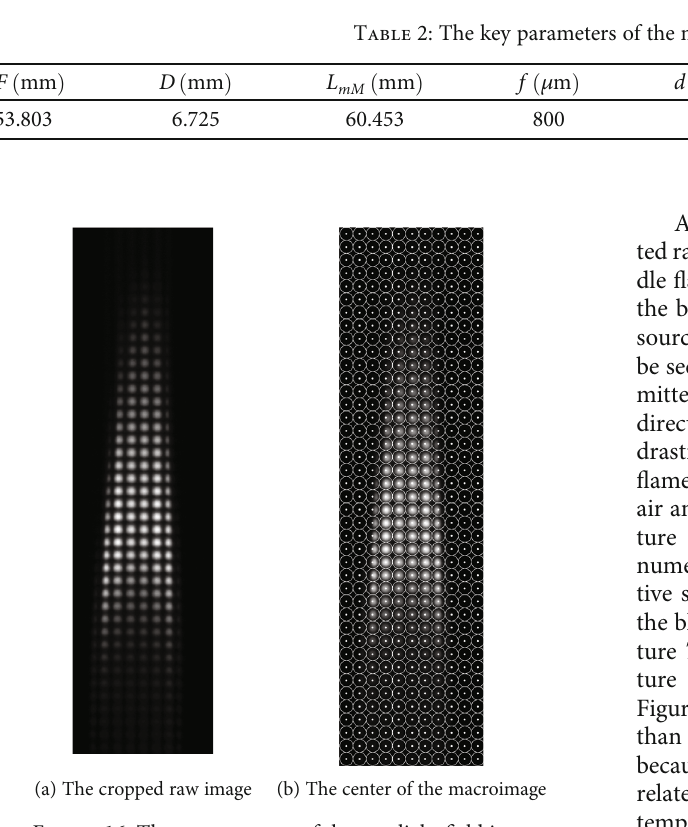
key geometry and optical parameters of the measurement system are listed in Table 2.